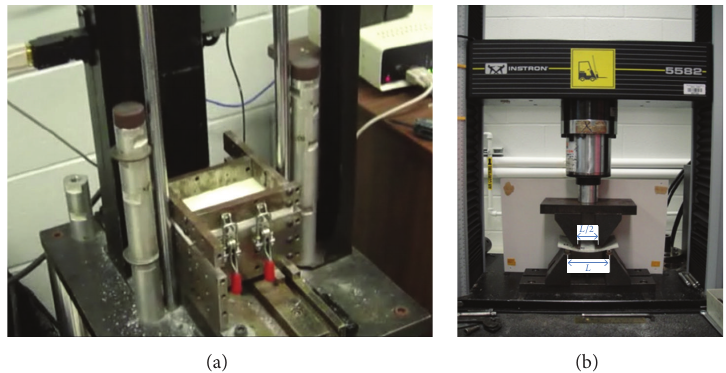
Figure 5: Set-up used during (a) the drop-weight impact testing and (b) postimpact four-point